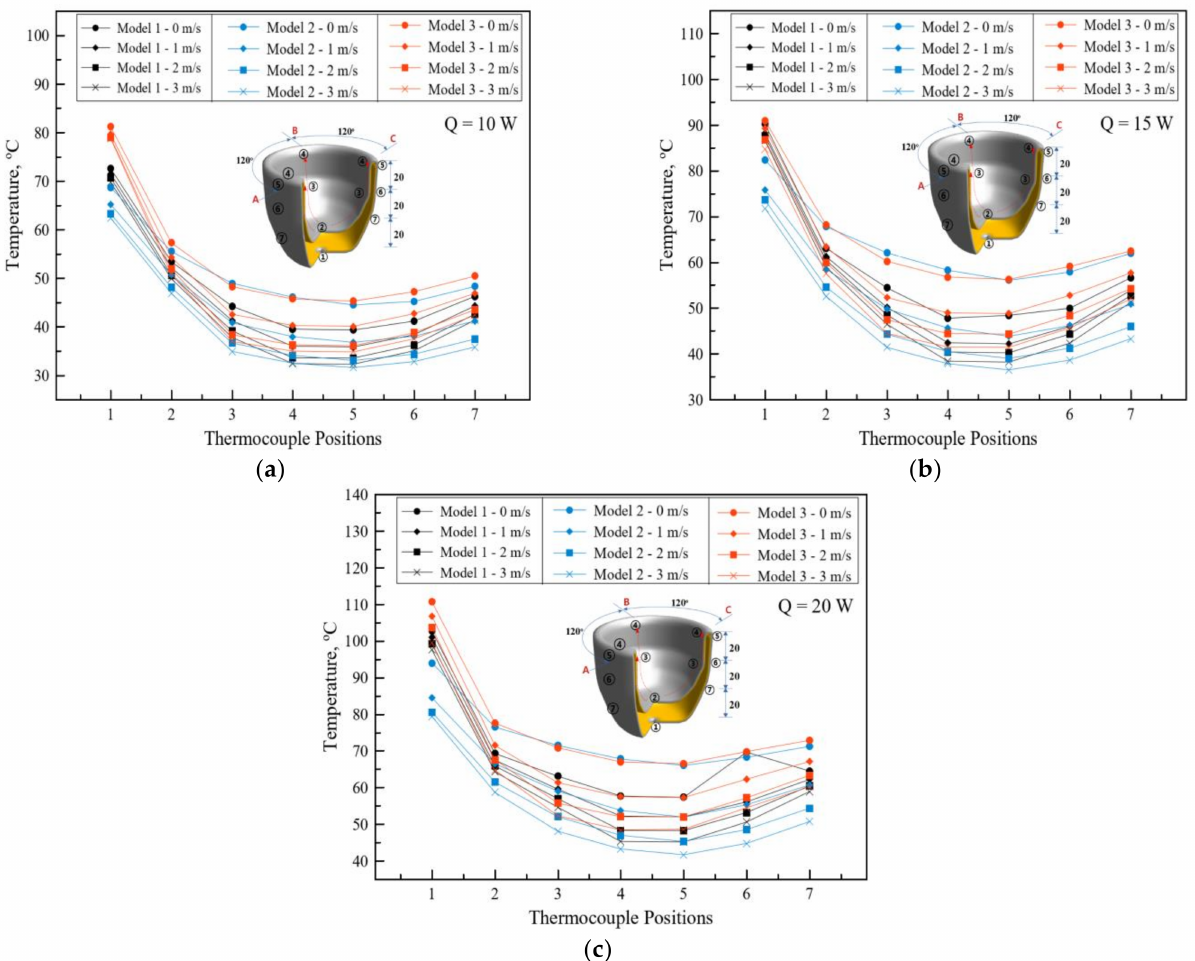
Figure 8. Temperature profile of the surface. ( a ) Q = 10 W. ( b ) Q = 15 W. ( c ) Q = 20 W. Temperature profiles in different angular positions (A, B, and C